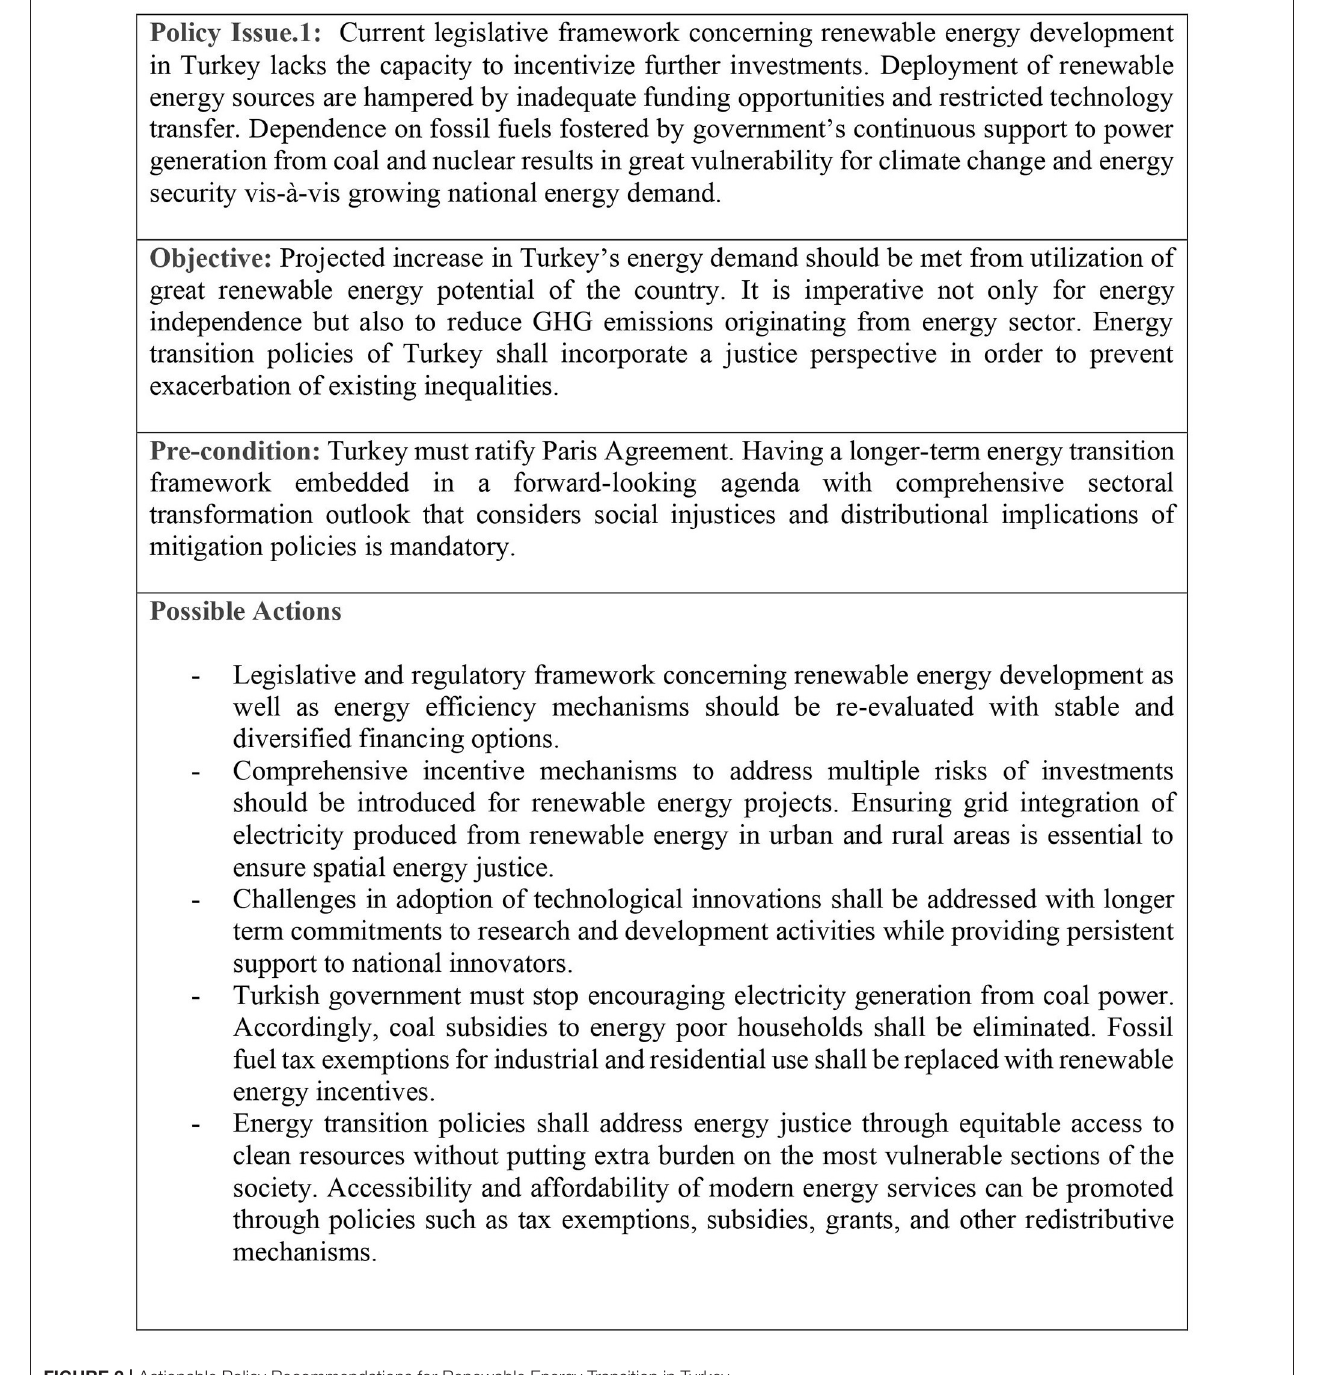
include quantitative information on estimated running costs can provide leverage effect ( Mock, 2016). One of the greatest novelties to be introduced with innovative, clean and cost-effective solutions in transport systems is Emissions in Respect of the Marketing of New Passenger Cars. Available online at: http://data.europa.eu/eli/dir/1999/94/2008-12-11